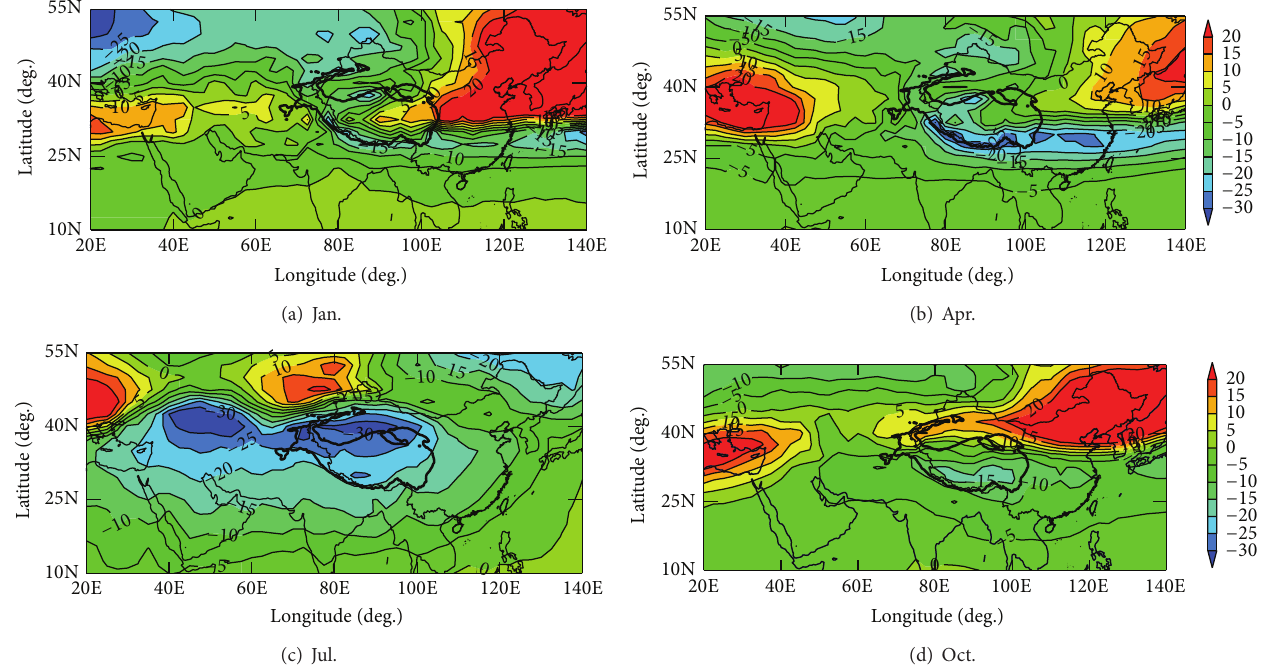
Figure 2: The same as Figure 1, but for zonal deviations of tropopause pressure (unit: hPa).